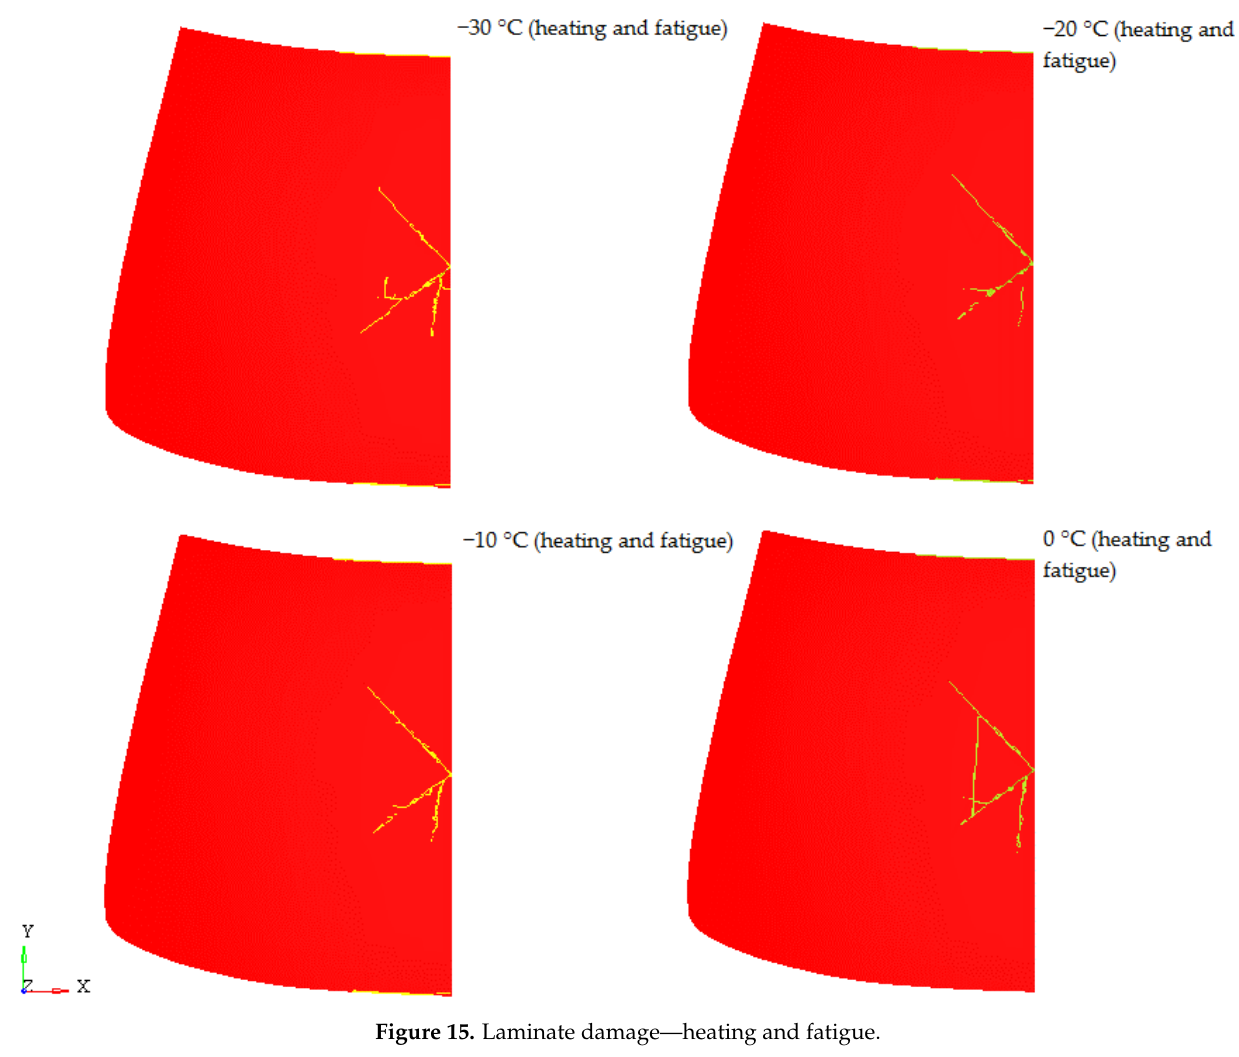
Figure 15. Laminate damage—heating and fatigue.